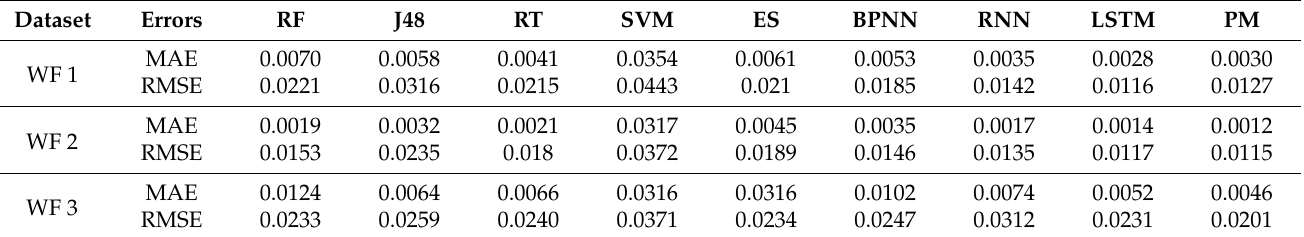
Table 5. Comparison of related forecasting models with the proposed model in terms of Normalized MAE and RMSE forecasting